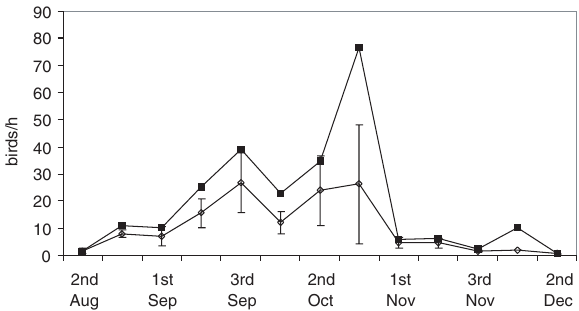
F IG . 6. – Distribution, in ten-day periods, of the migratory passage (birds/h) from Estaca de Bares, mean ± SE of those years between 1967 and 2000 for which information is available. Open symbols = westward movements; solid symbols = maximum daily westward